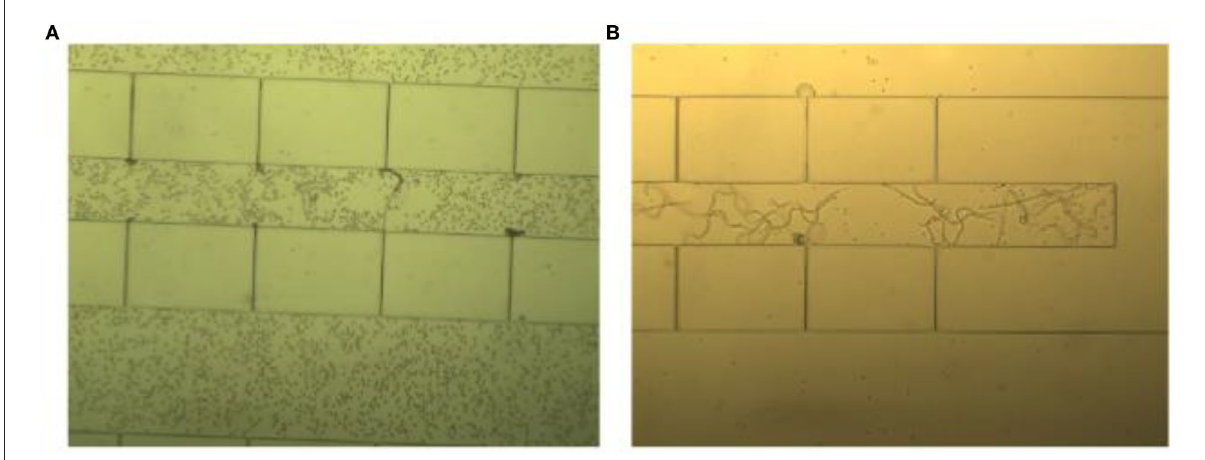
FIGURE6 A 20x diluted blood sample was injected by hand in two steps. (A) The first step involved blood sample injection, resulting in the retention of blood cells in the passage channel with trapped microfilariae. (B) The second step involved washing using normal saline solution, resulting in good visibility of the microfilariae.